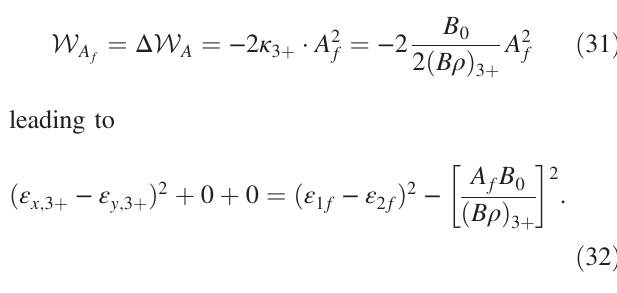
ffiffiffiffiffiffiffiffiffiffiffiffiffiffiffiffiffi p ε β ε β ¼ 4 . 166 mm 2 , and the x x y y